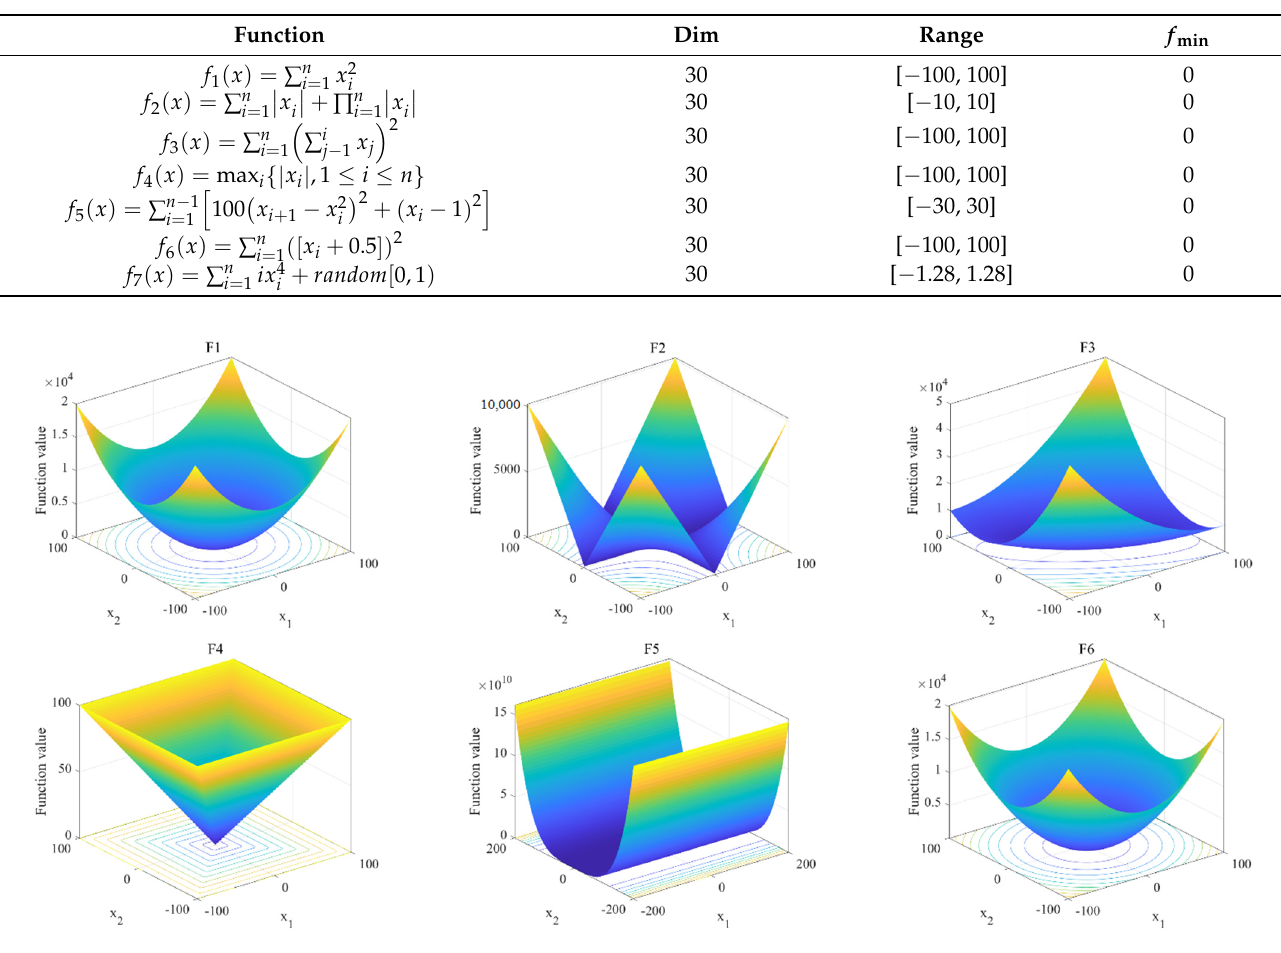
Table 1. Unimodal benchmark functions.